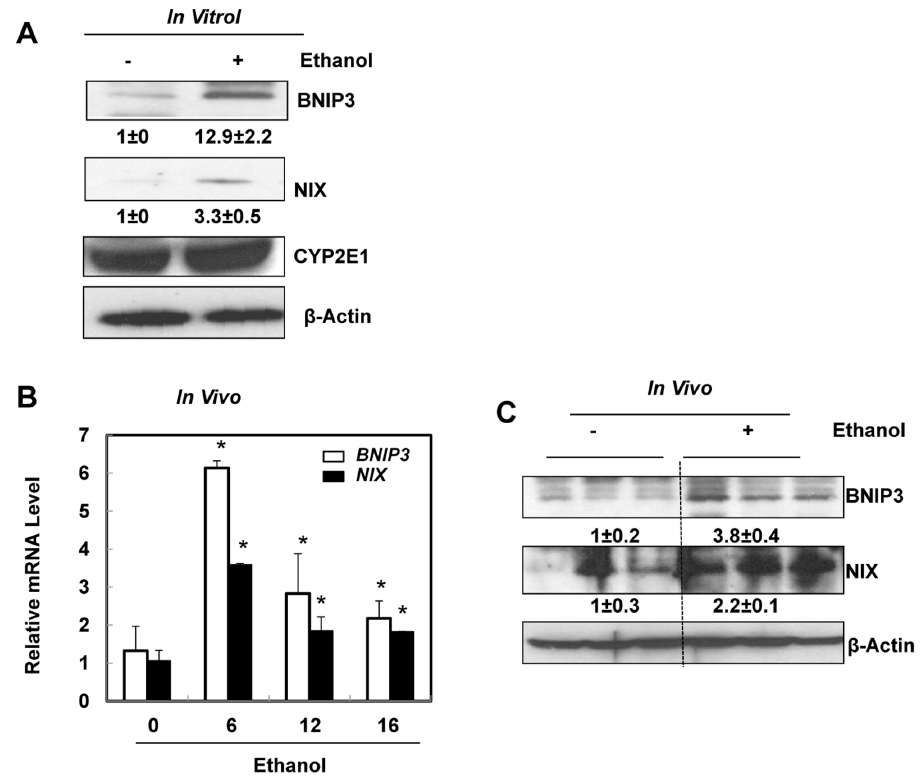
Fig. 1. Acute ethanol treatment increased expression of BNIP3 and NIX in primary hepatocytes and mouse liver. Primary cultured mouse hepatocytes were treated with ethanol (80 mM) for 6 hours. Densitometry was performed and data are presented as a ratio vs control (n 5 3). ( A ) Total cell lysates from cultured hepatocytes were subjected to western blot analysis. ( B ) Male C57BL/6 mice were treated with either water or ethanol (4.5 g/kg) by gavage for 6, 12 or 16 hours. Hepatic mRNA was isolated and real-time RT- PCR was performed as described in the Materials and Methods. Data are presented as means ¡ SE (n 5 4– 6). * p , 0.05, vs 0 hour control. One way ANOVA with Scheffe´’s post hoc test. ( C ) Mice were treated as in ( B ) and total liver lysates from the mice (16 hours treatment) were subjected to western blot analysis. Densitometry was performed and data are presented as a ratio of control (n 5